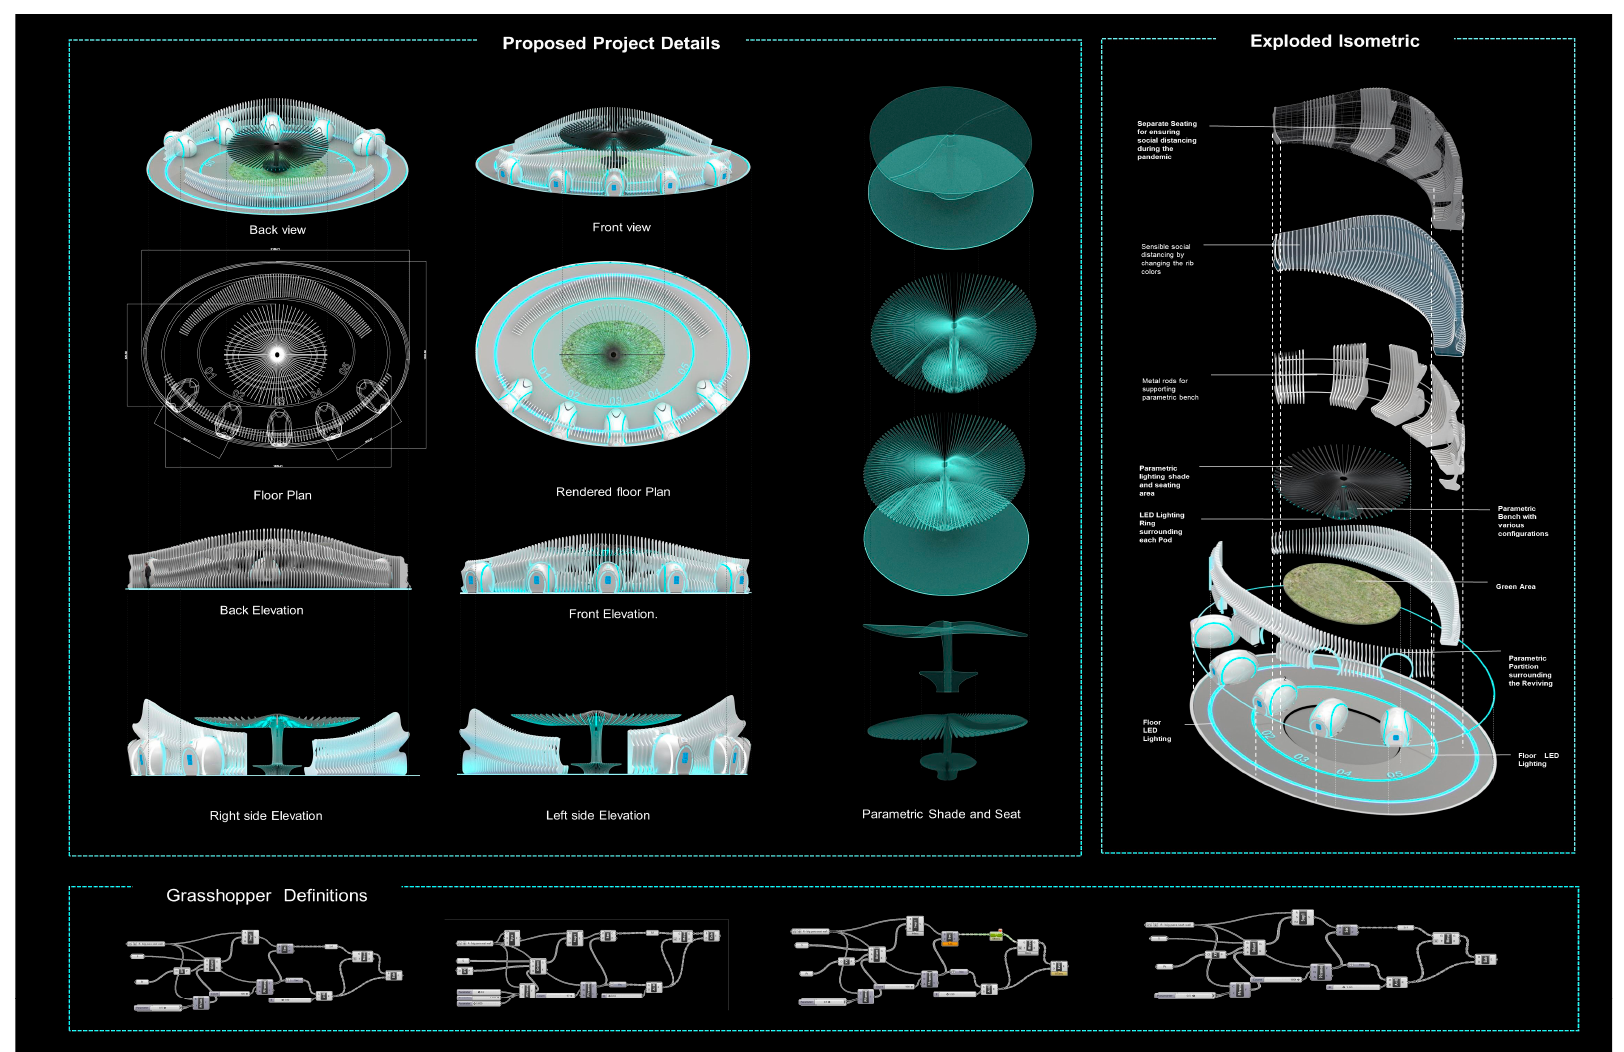
Figure A4. Samples of the posters (Poster1) displayed on 6 February 2022 on DAU campus in the CADD Female Exhibition.